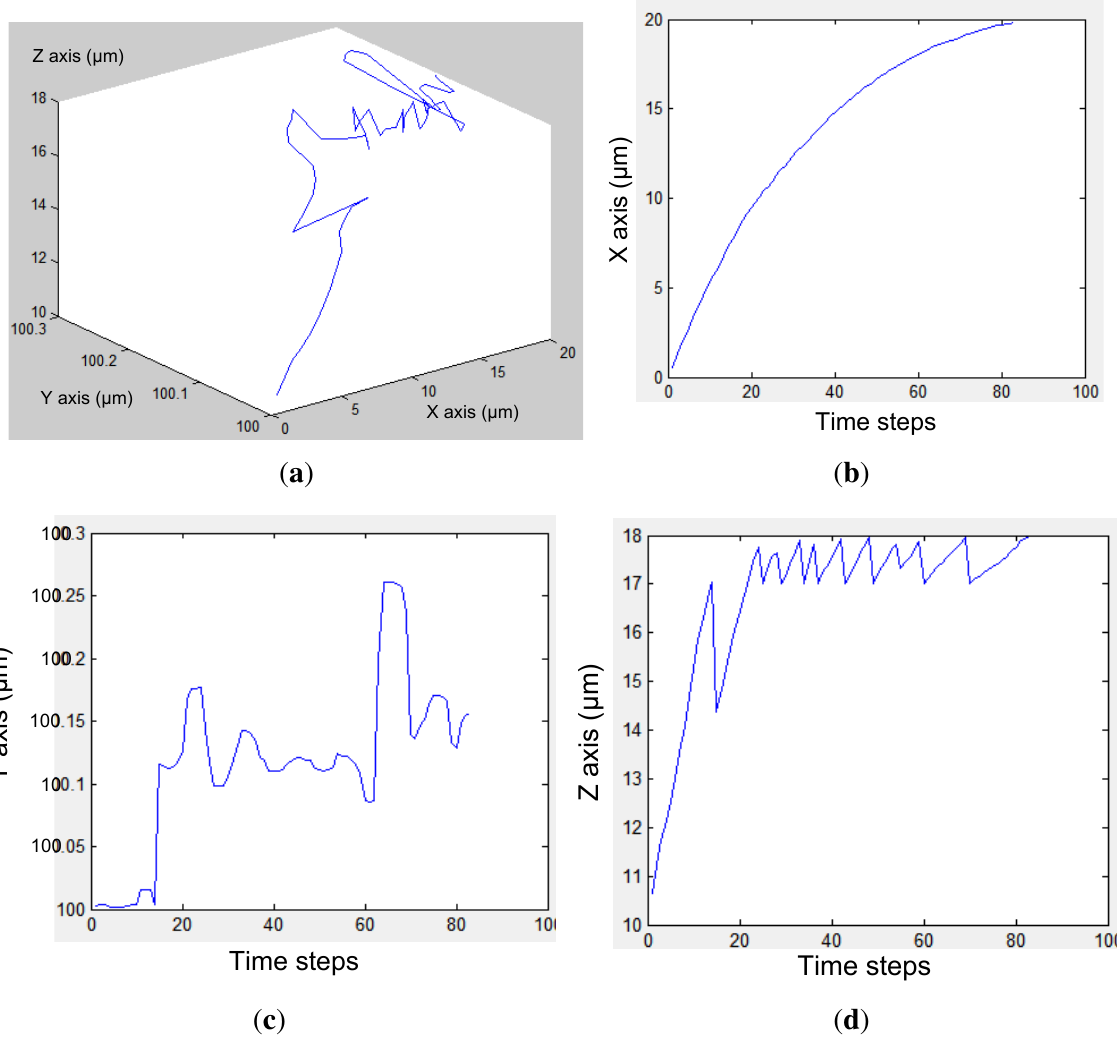
Figure 10. ( a ) Particle 3D-displacement in an 8-electrode architecture, where ( b – d ) show X, Y and Z displacements respectively. X, Y and Z axis are defined in Figure